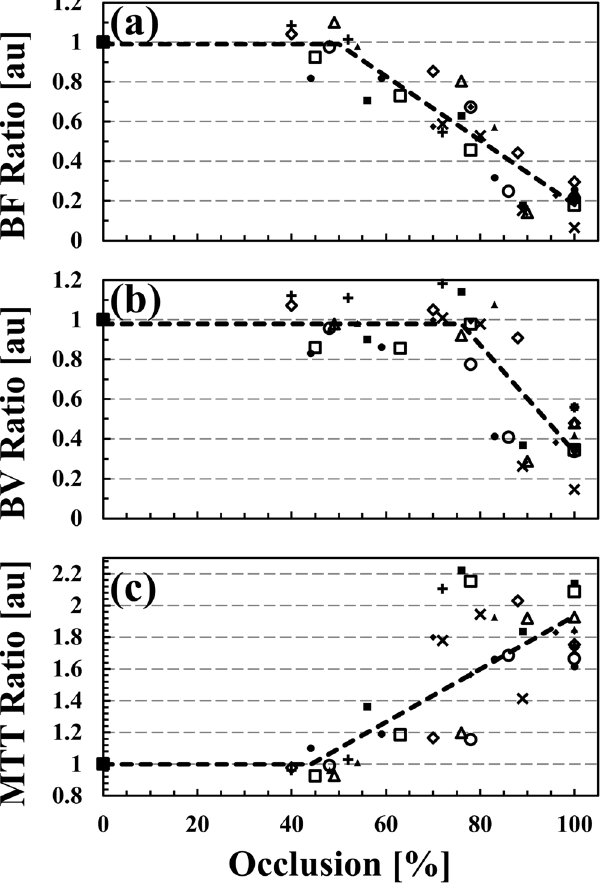
Figure 4. Scatter plots of normalized perfusion ratios of blood flow ( BF , a ), blood volume ( BV , b ), and mean transit time ( MTT , c ) for all 10 pigs and for all occlusions displayed as markers (plus sign, multiple sign, open triangle, filled triangle, open circle, filled circle, open square, filled square, open diamond, filled diamond). Perfusion values from each pig is represented with individual markers. Results from piece-wise linear function fitting that contains two segments (Eq. 4) is also displayed as dashed lines. Fitted data demonstrates occlusion level onsets, A